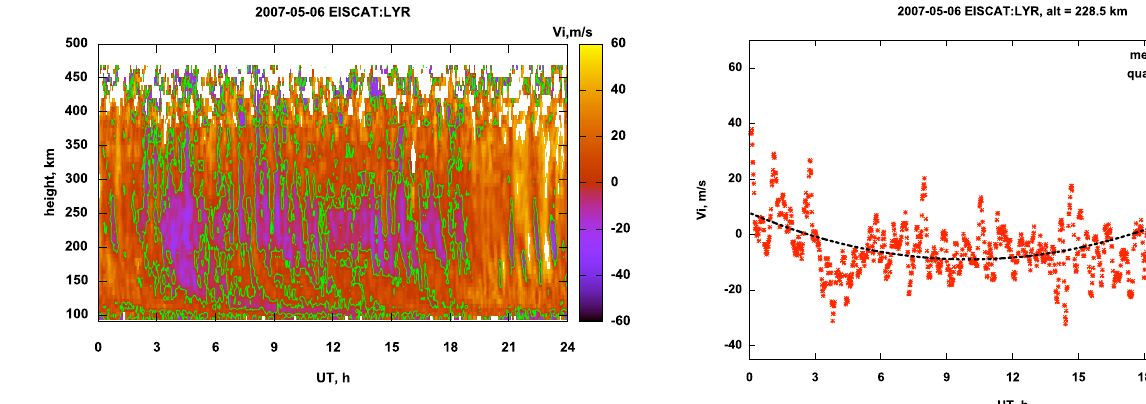
Fig. 3. The measured line-of-the-sight ion velocity data on 6 May 2007. Blank spots represent data points outside of the col- orscale range.